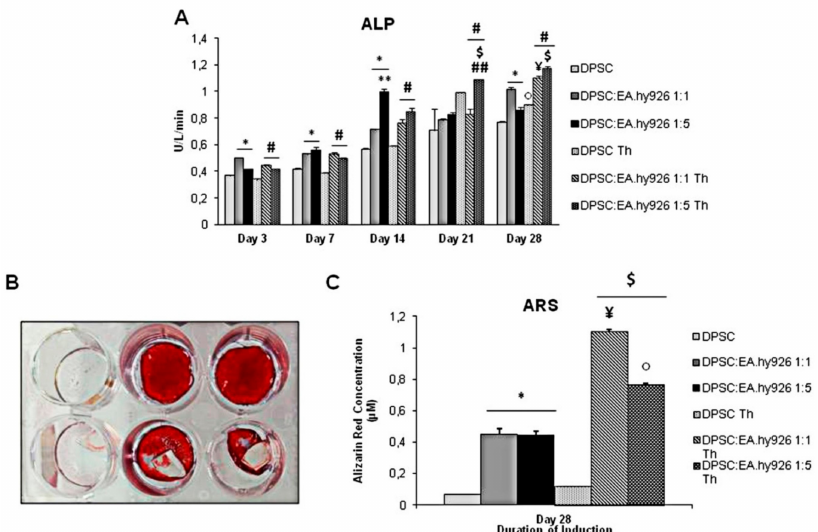
Figure 2. ( A ) Quantitative determination of the ALP levels in the induced cultures at di ff erent time points. All results are represented as the mean values ± SD ( n = 3). * DPSC:EA.hy926 1:1 and 1:5 vs. DPSC of the same day of culture, p < 0.05; $ DPSC:EA.hy926 1:5 Th vs. DPSC:EA.hy926